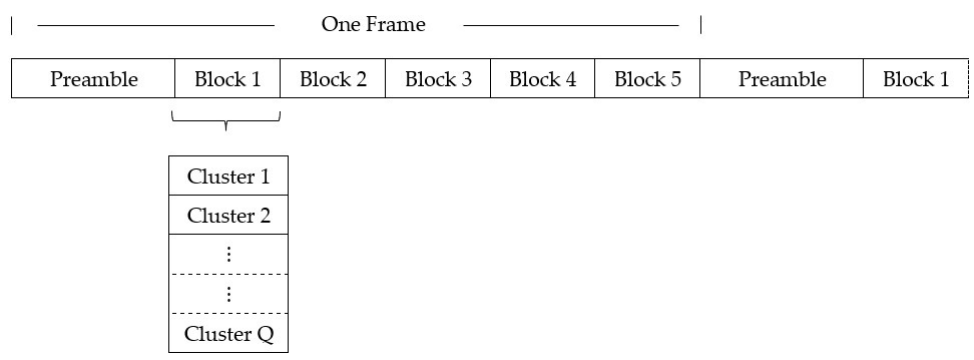
Figure 3. Cluster structure in UA OFDM frame.